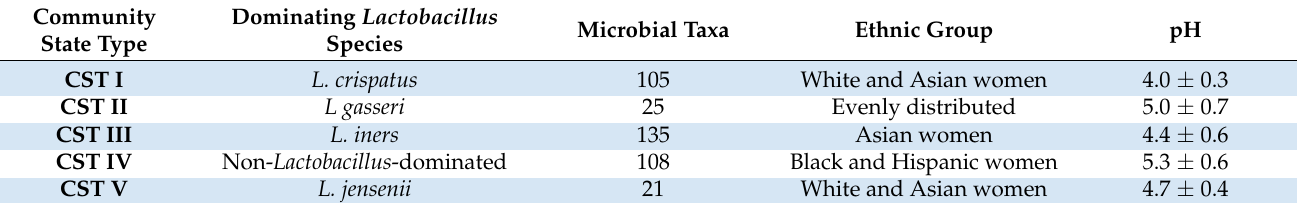
Table 1. Community state